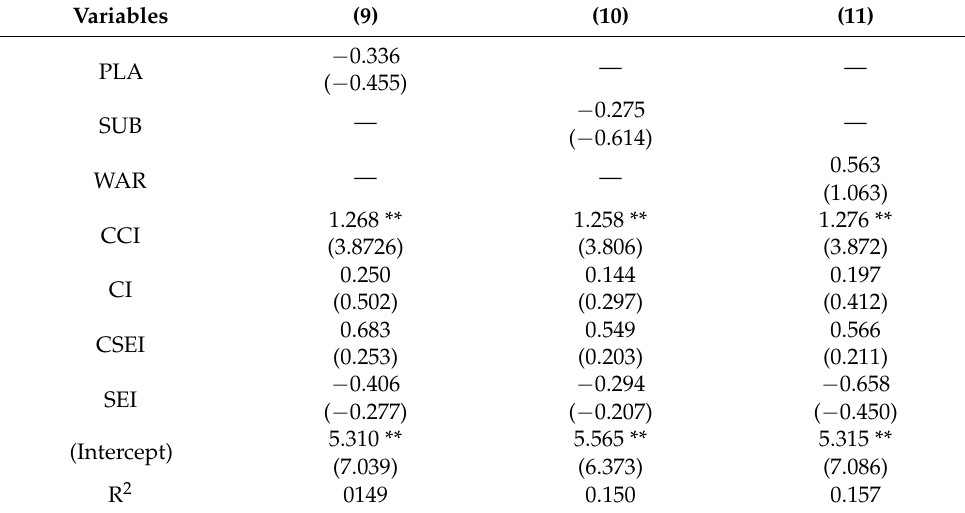
Table 6. Robustness test: climate